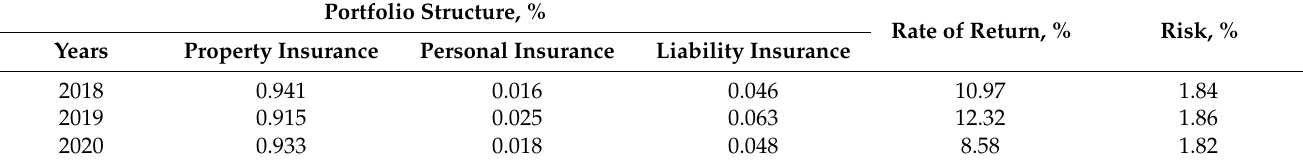
Table 4. Structure of insurance portfolios, profitability, and risk of Renaissance Insurance